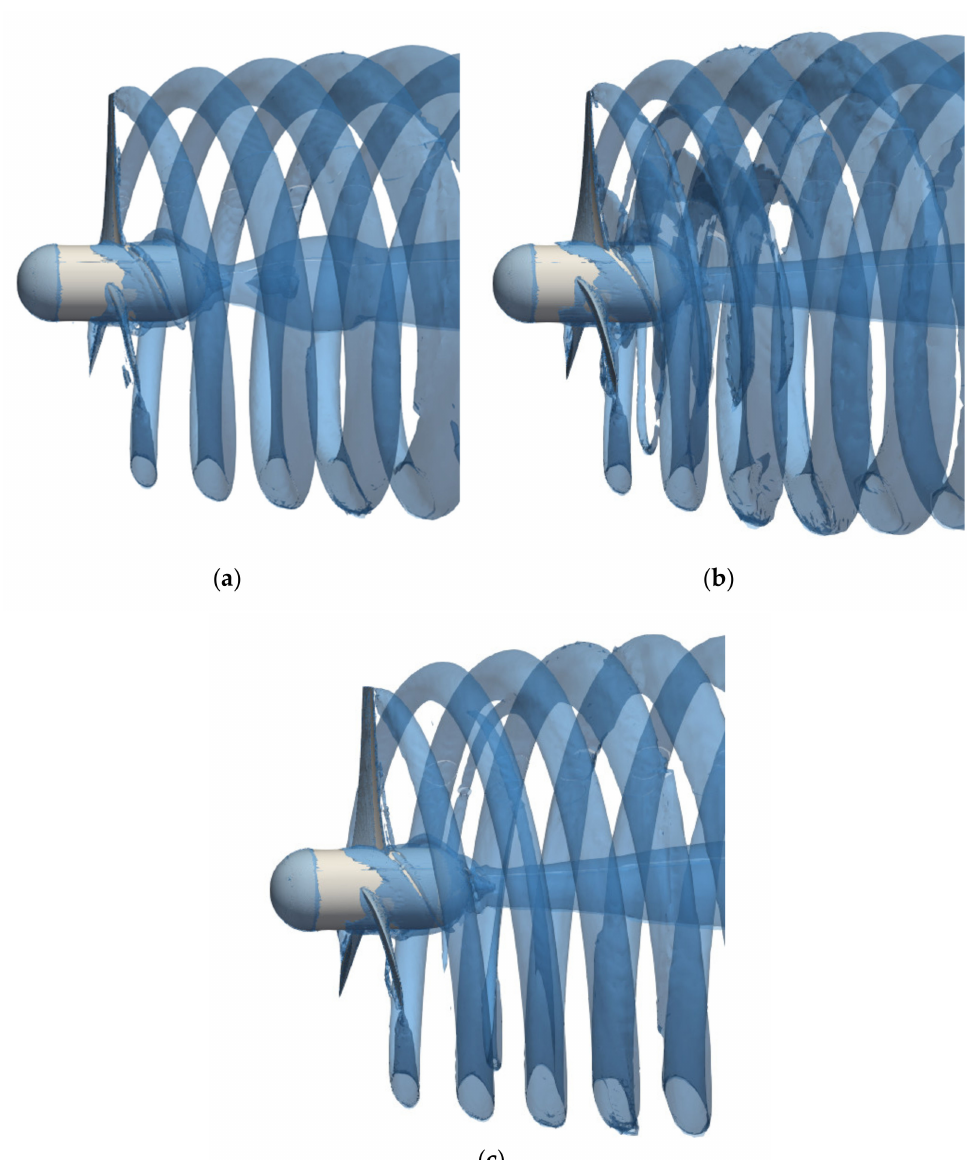
Figure 9. Vortical structures in HKT wake as identified by the Q-criterion (iso-surface Q = 0.1): ( a ) Initial geometry; ( b ) optimized geometry A.1; ( c ) optimized geometry